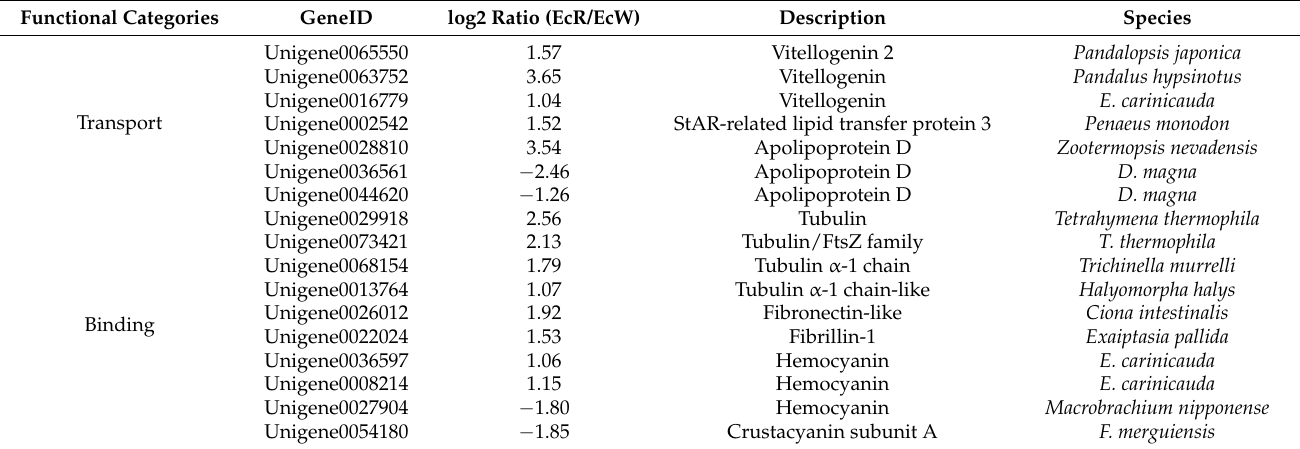
Table 4. Transport- and binding-related